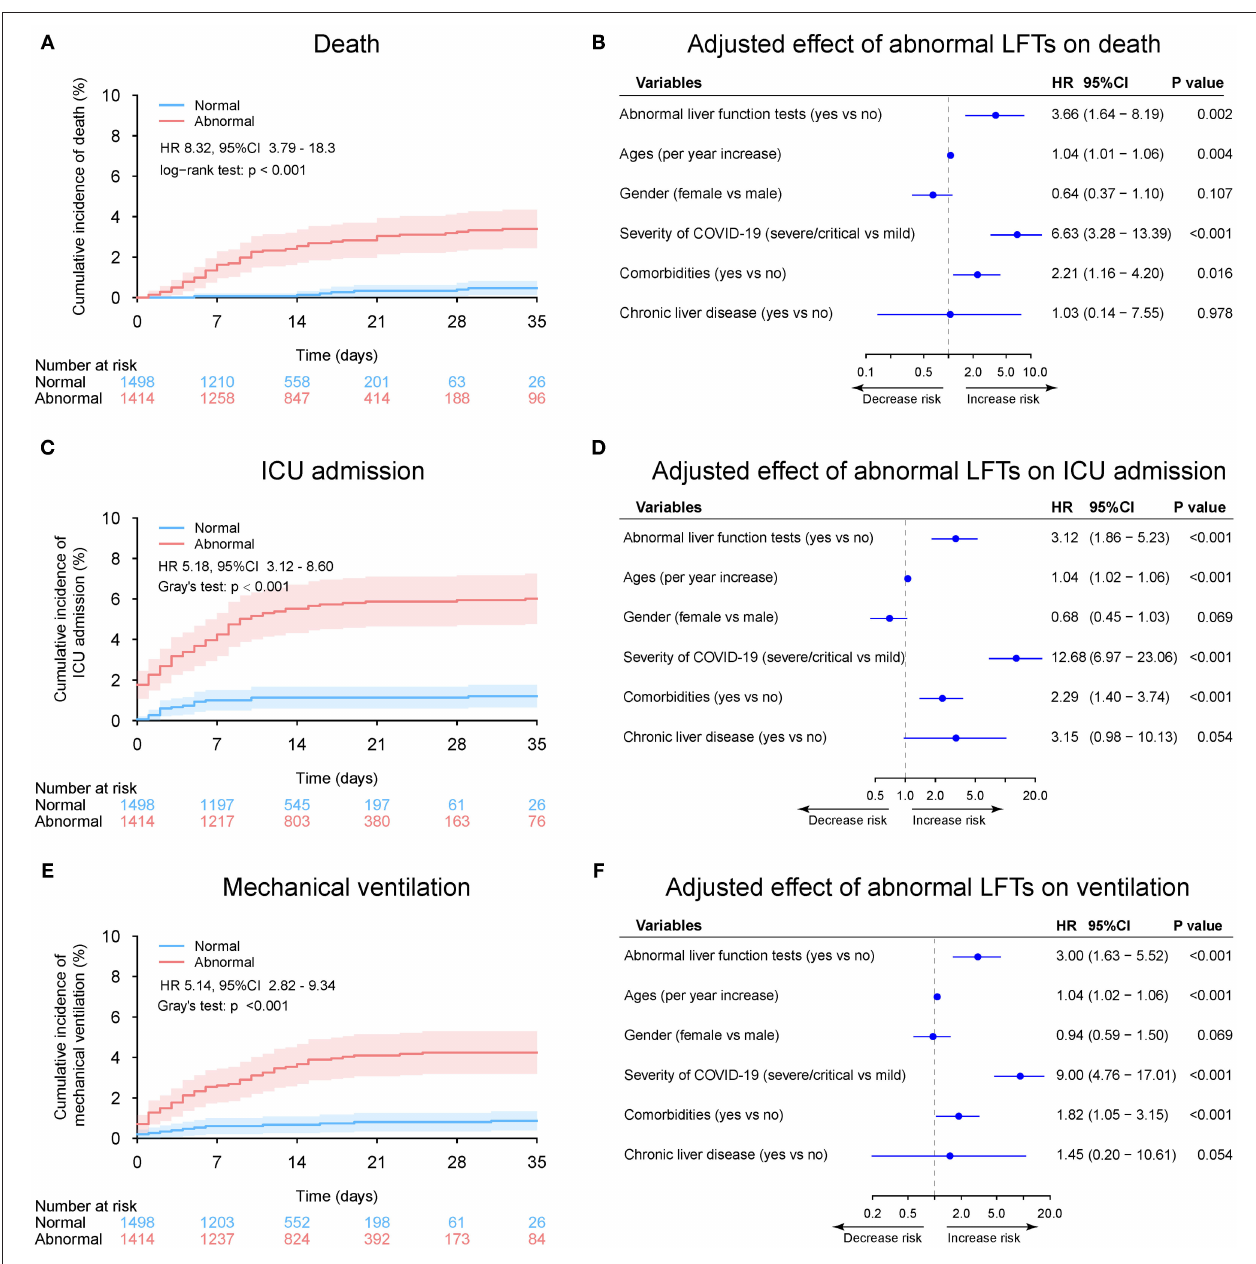
FIGURE 5 | Outcome analysis according to admission abnormal vs. normal liver function tests (LFTs). (A) Cumulative incidence of death in patients with abnormal vs. normal LFTs on admission. (B) Independent effect (hazard ratio with 95% confidence intervals) of admission abnormal vs. normal LFTs on all-cause mortality adjusted for potential confounders using the Cox multivariable regression models. (C) Cumulative incidence of ICU admission in patients with abnormal vs. normal LFTs on admission based on competing risk approach (the Fine and Gray method) with death being the competing events. (D) Independent effect (hazard ratio with 95% confidence intervals) of admission abnormal vs. normal LFTs on ICU admission adjusted for potential confounders using the Cox multivariable regression models. (E) Cumulative incidence of mechanical ventilation in patients with abnormal vs. normal LFTs on admission based on competing risk approach (the Fine and Gray method) with death being the competing events. (F) Independent effect (hazard ratio with 95% confidence intervals) of admission abnormal vs. normal LFTs on mechanical ventilation adjusted for potential confounders using the Cox multivariable regression models. Comorbidities include hypertension, cardiovascular disease, diabetes, chronic pulmonary diseases, cerebrovascular disease, malignancy, and autoimmune disease. Chronic liver diseases include hepatitis B virus infection, hepatitis C virus infection, and autoimmune liver disease. LFTs, liver function tests; ICU, intensive care unit.